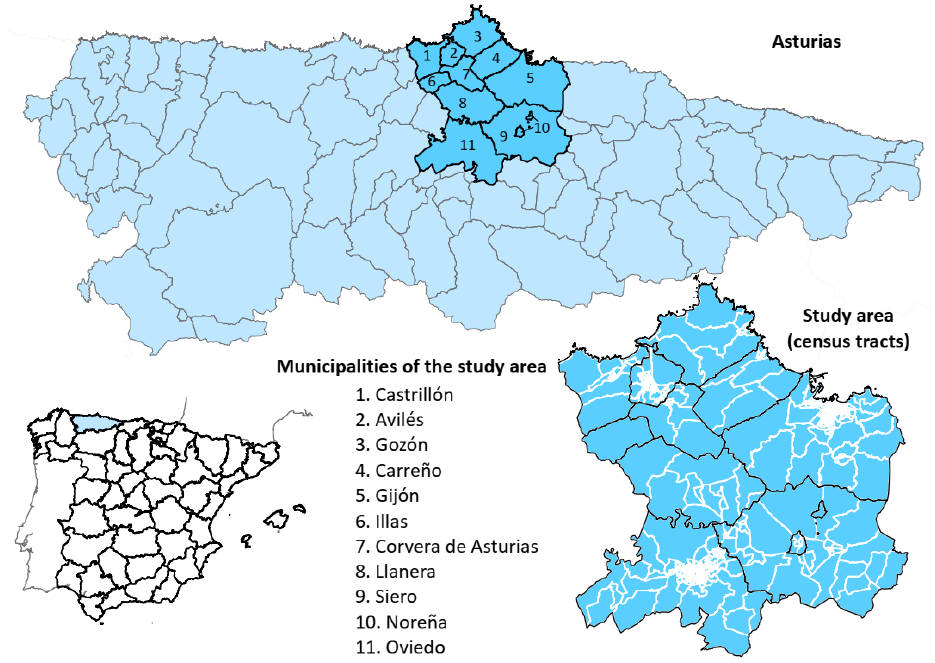
Figure 1. Location of the study area. Asturias is an Autonomous Community of Spain, located in the north of the country. The study area is comprised of eleven municipalities in the central area of the region.